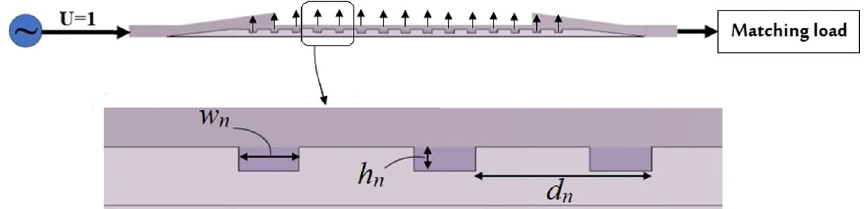
Fig. 2 A dielectric waveguide with non-identical